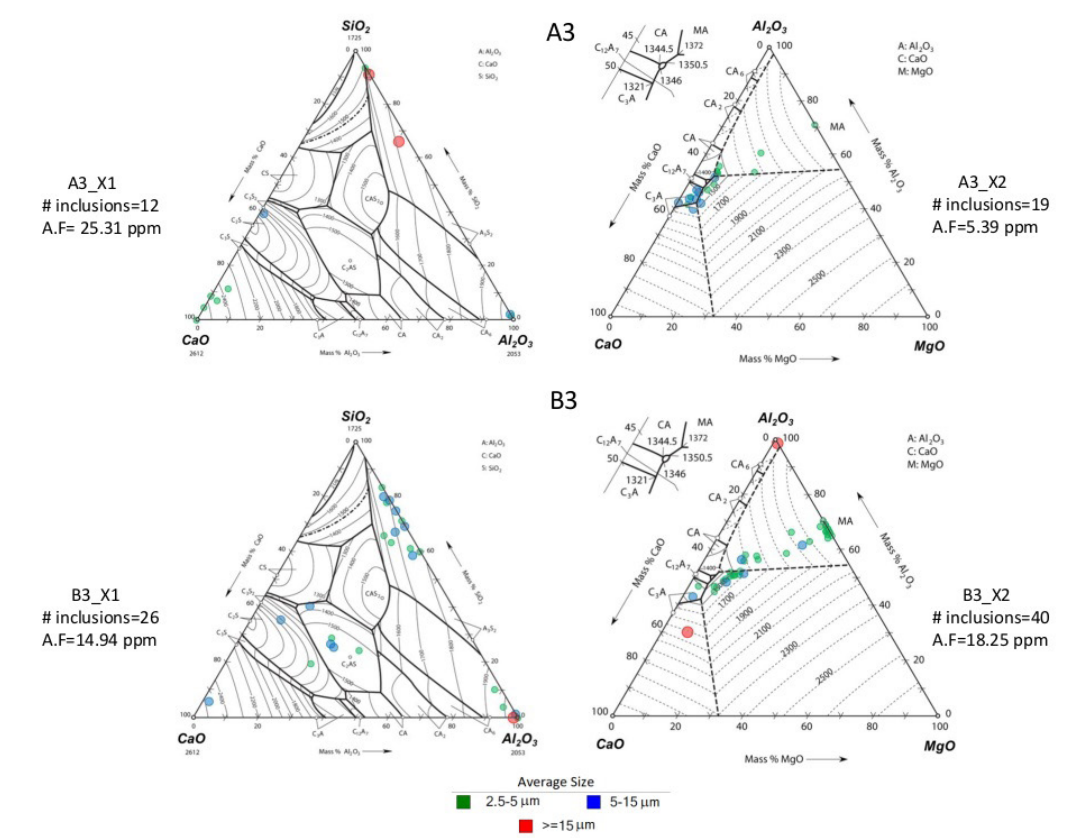
Figure 11. Distribution of composition, size and area fraction (AF) of inclusions in steel. Samples X1 (after vacuum) and X2 (in the tundish). Ternary diagrams